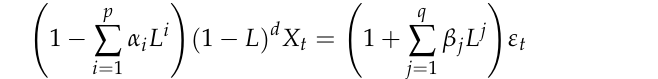
Figure 3. Spatial distribution of mean monthly precipitation data totals from 1973 – 2021 in South Korea. The annual precipitation is approximately 11,250 mm (1973 – 2021 average), with more than 60% of the annual rainfall occurring between June and August. Boxplots of the monthly precipitation from 1973 to 2021 are plotted in Figure 4. The annual periodicity involves obvious precipitation increases in the summer, with maximums occurring in July and August corresponding to the summer monsoon in Asia; precipitation is lower at other times of the year.